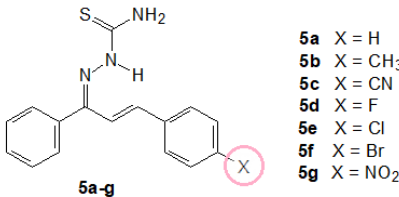
Figure 1. Synthetic hybrid chalcone-thiosemicarbazone structures under study.